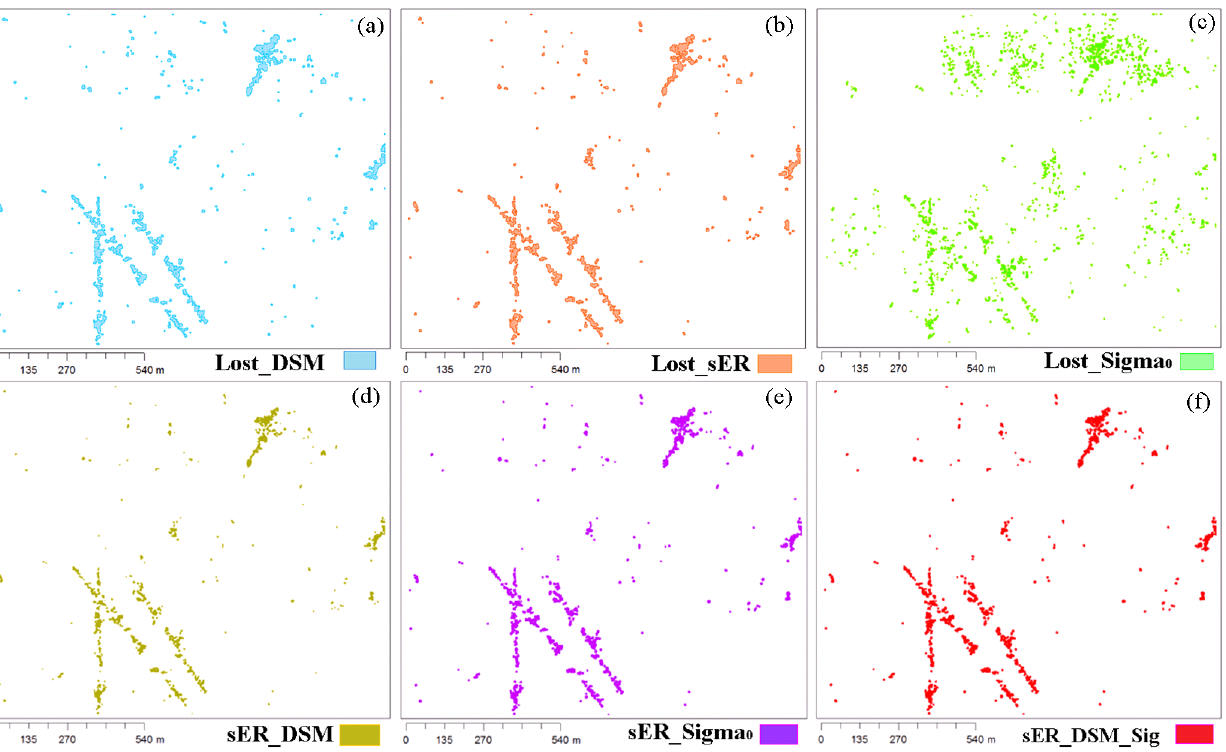
Figure 3. Final forest reduction after morphological operation ( a ) DSM; ( b ) Echo ratio; ( c ) Sigma 0 ; ( d ) Echo ratio and DSM; ( e ) Echo ratio and Sigma 0 ; ( f ) Echo ratio and DSM and Sigma 0